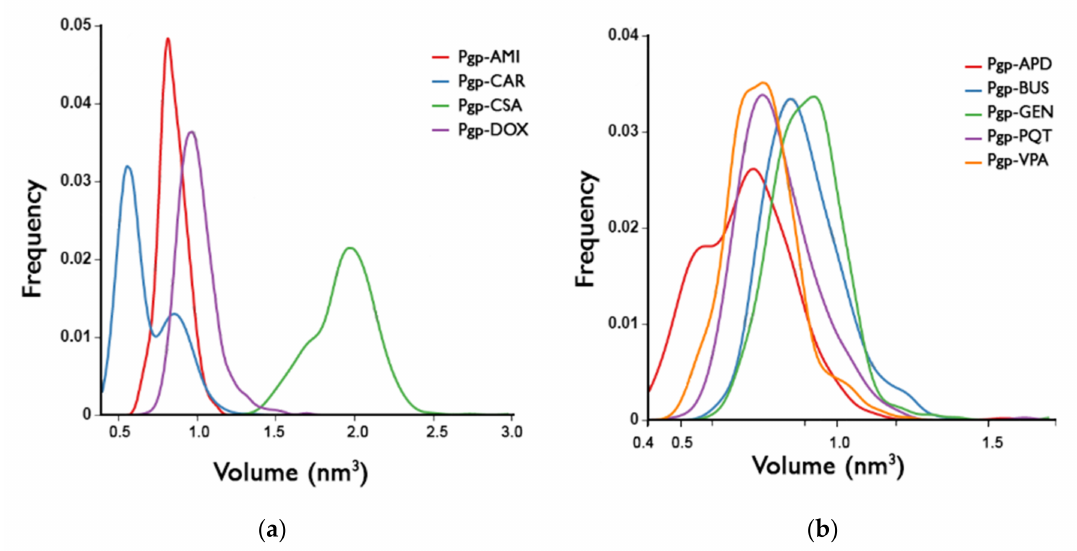
Figure 13. Distributions of the internal cavity volumes for ( a ) active-bound systems and ( b ) non- active-bound systems.